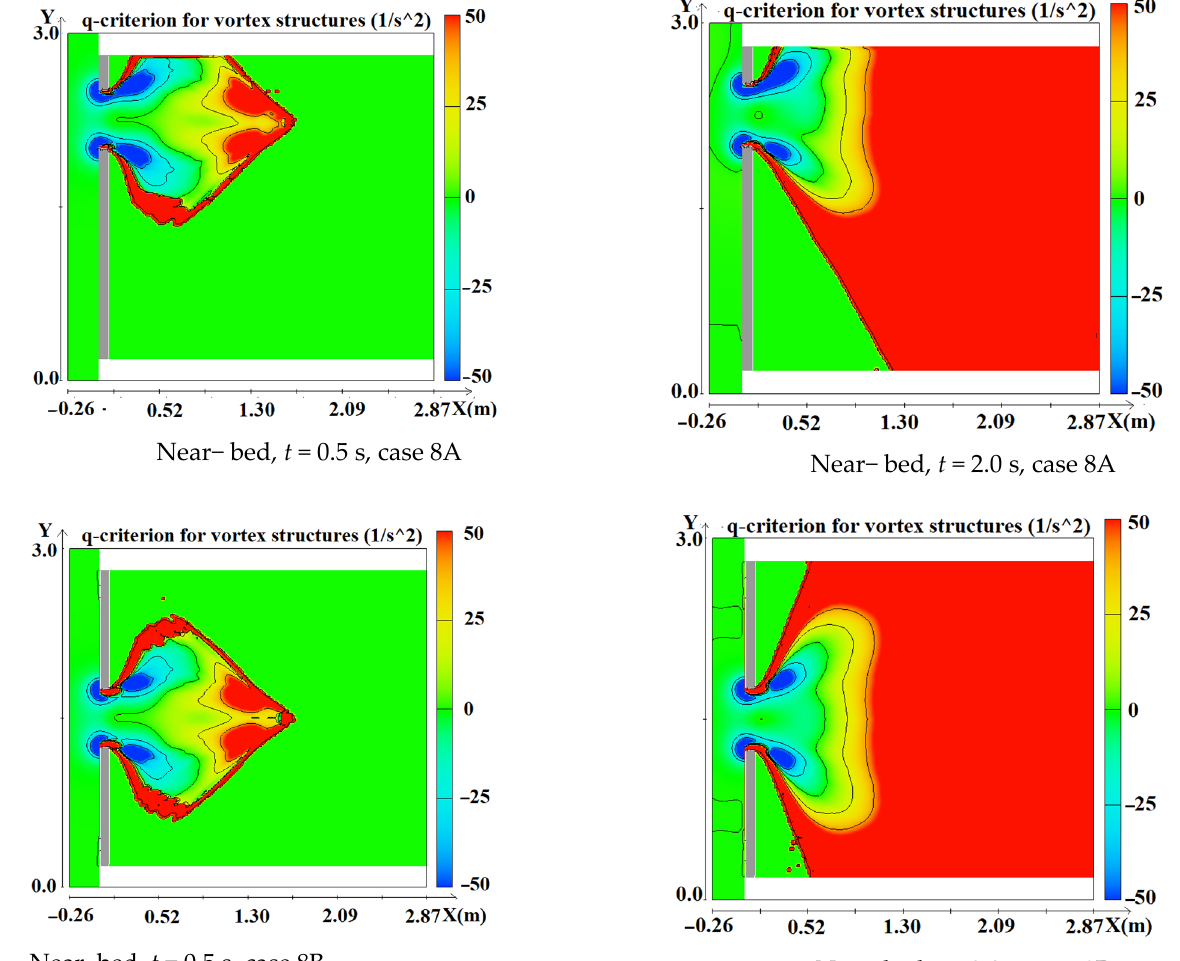
Figure 14. Near – bed iso – surface map of q – criterion at a) t = 0.5 s and b) t = 2.0 s in cases 8A and 8B. Figure 14. Near − bed iso − surface map of q − criterion at t = 0.5 s and t = 2.0 s in cases 8A and 8B.